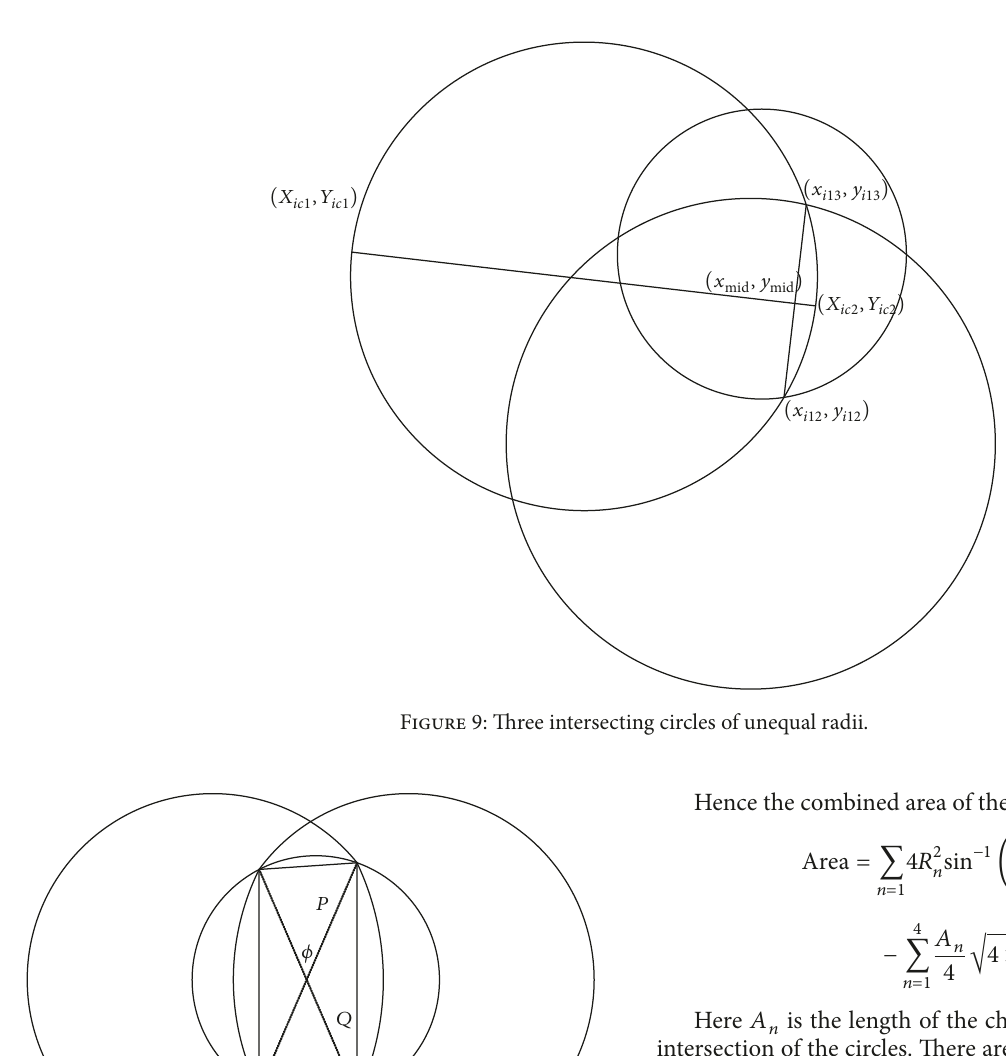
(iii) The crisp circle which touches the inner circles of the circular triangle and its neighbouring triangles is either tangent to the innermost circle and internally